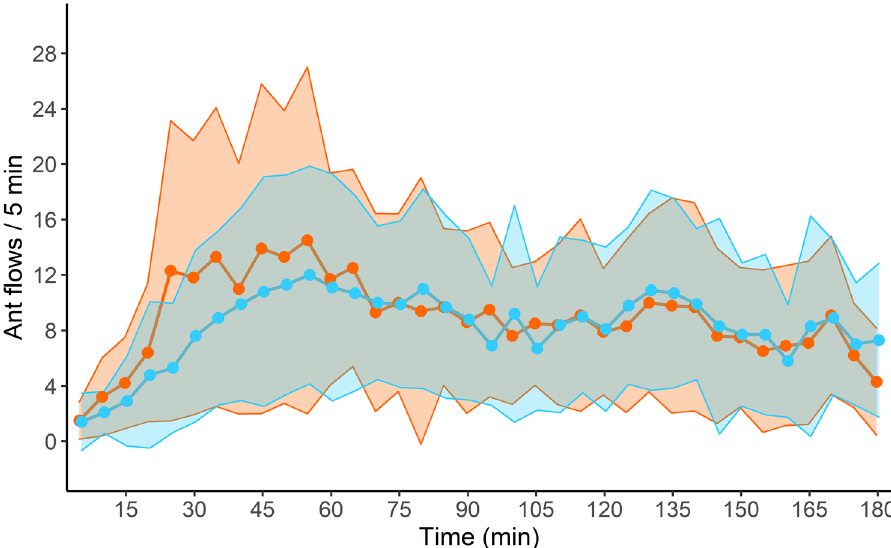
Figure 6. Collective experiment: ant flows arriving at the UFA (in blue) and the CFA (in orange) every 5 min during the 3-h experiment. Values were averaged over the number of workers entering the foraging area per 5 min of observation. Circles and shadings represent the mean ± standard deviation, respectively (N = 10 colonies).